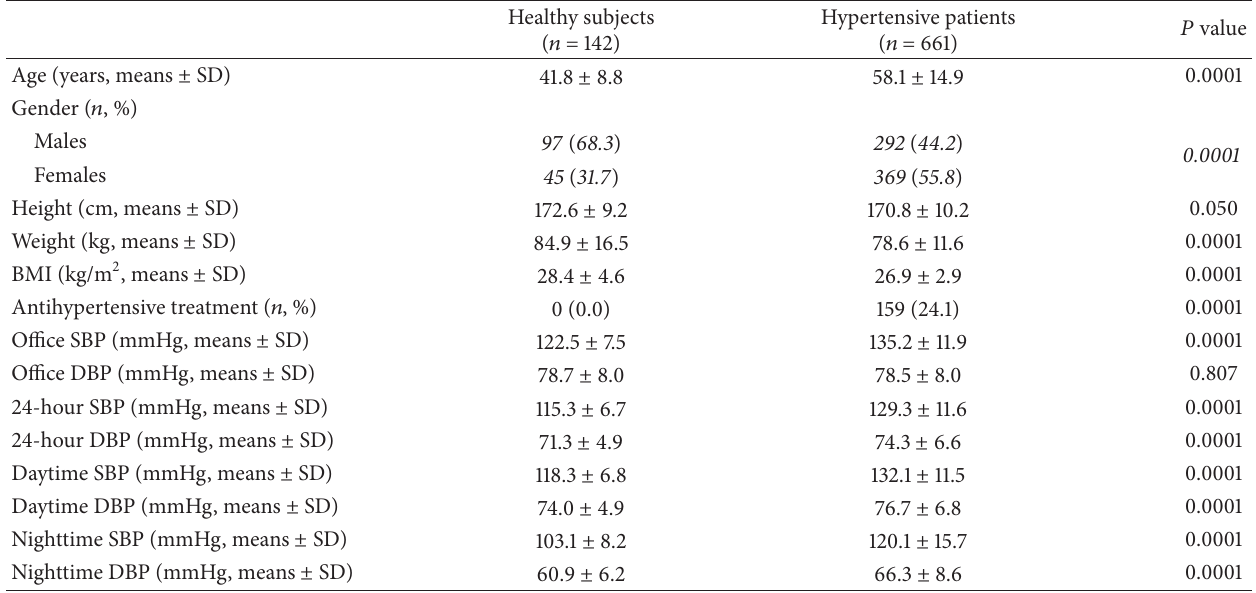
Table 1: Demographic and clinical data of healthy subjects and hypertensive